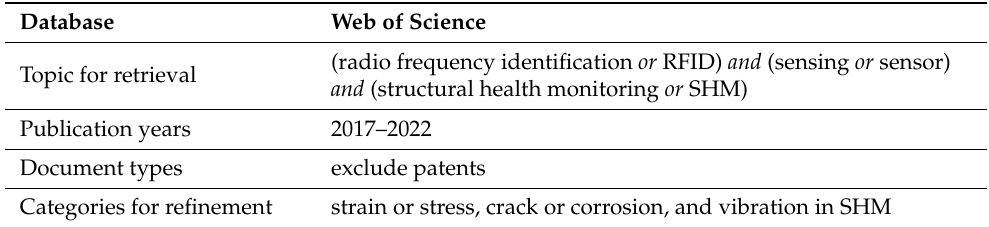
Table 1. Detailed information of retrieval and